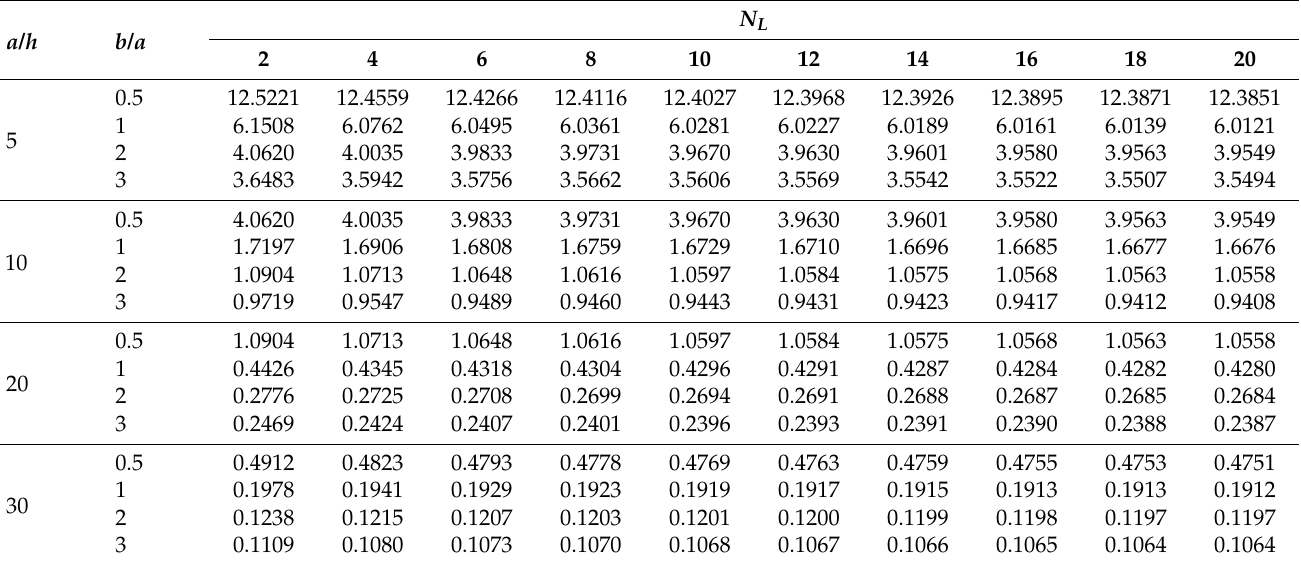
Table 8. Effect of the total number of layers on dimensionless critical buckling load of FG-O